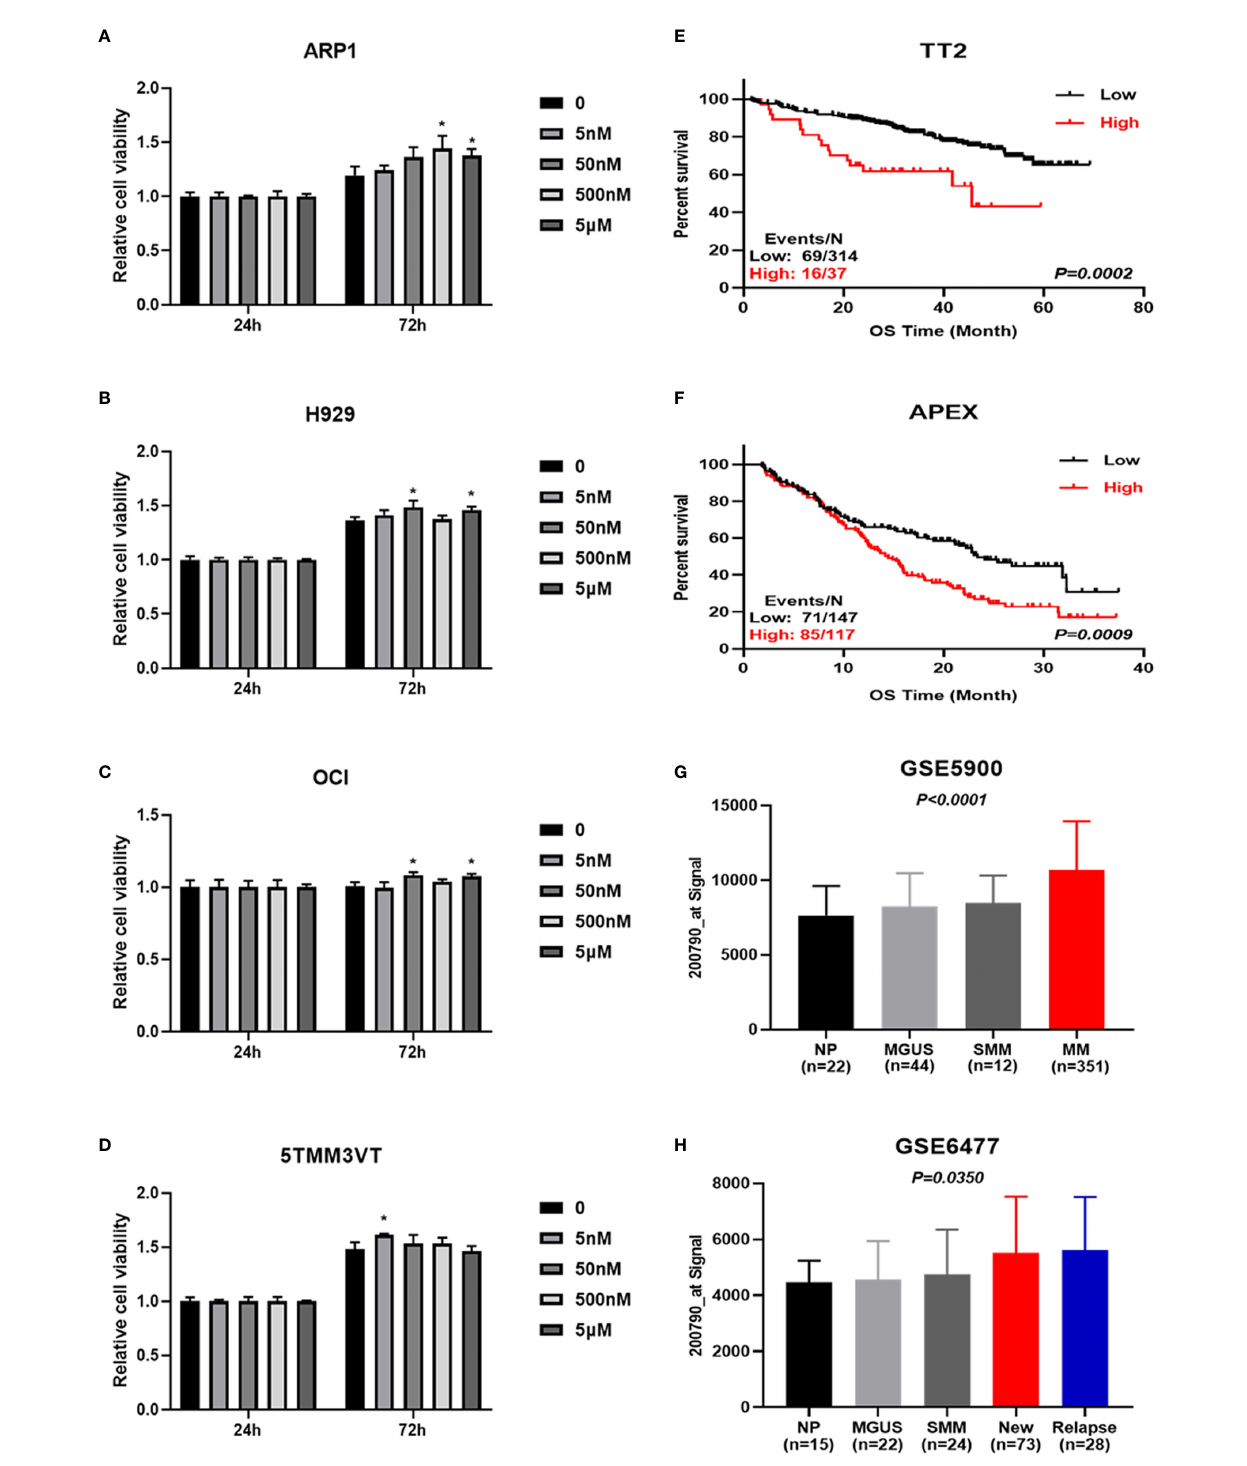
FIGURE 7 | Increased ODC1 expression is associated with poor prognosis in MM. (A – D) Arginine and its metabolite promoted ARP1, H929, OCI, and 5TMM3VT cell proliferation. * P < 0.05. (E, F) High ODC1 expression in MM patients was correlated with poor OS in TT2 cohort, and APEX phase III clinical trial by log-rank test. (G, H) The mRNA level of ODC1 from NP, MGUS, SMM, and MM was signi fi cantly increased in MM samples by ordinary one-way ANOVA